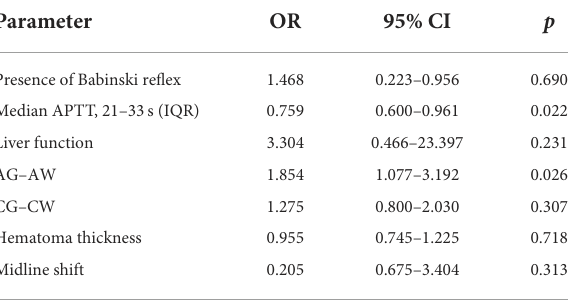
TABLE 4 Multivariable analysis: OR values in surgical and non-surgical groups (surgical group n = 38). Parameter